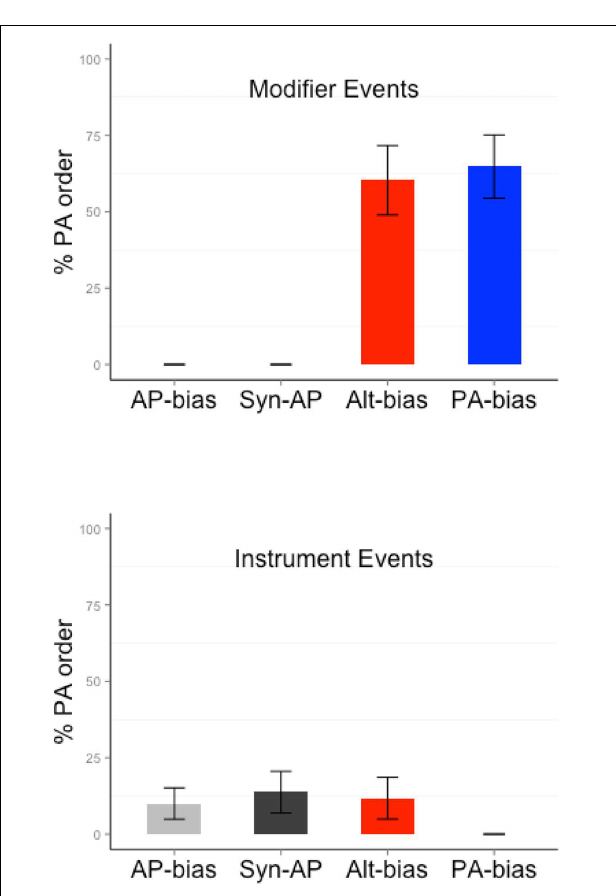
FIGURE 4 | Proportion of PA order responses produced with different verb and event types in Experiment